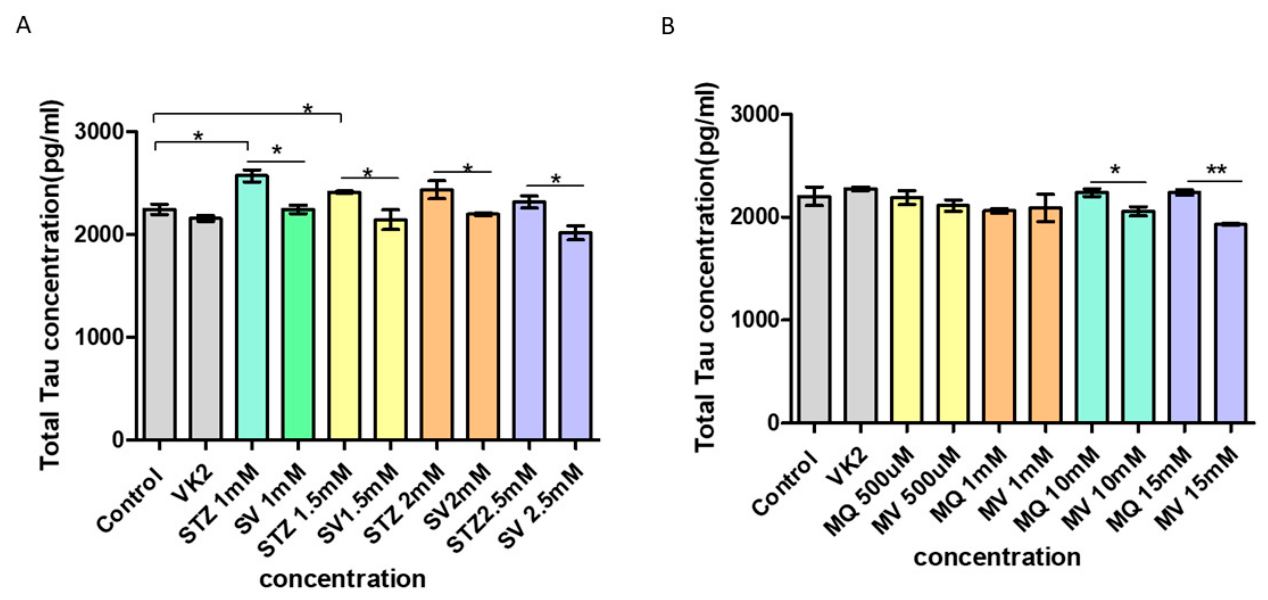
Figure 8. Measurement of total intracellular tau protein levels by ELISA in human SH-SY5Y neuroblastoma cells after ( A ) streptozotocin treatment and post-treatment with vitamin K2 (50 µ M) and ( B ) menadione treatment (MQ) and post-treatment with vitamin K2. A best-fit standard curve was plotted for the known protein concentrations using graph pad prism and absorbance values for unknown samples were interpolated on the standard curve to determine the concentration of target protein in each sample. The data are presented as mean ± SEM. Statistical analysis was performed using Student’s t -test and differences with p -value ≤ 0.05 were designated as significant. * p < 0.05, ** p < 0.01, and *** p < 0.001 denote significant differences compared to the control and between the treatment groups. [STZ—streptozotocin; VK2—vitamin K2; SV—post-treatment of streptozotocin (1–2.5 mM) treated cells with vitamin K2 (50 µ M); MQ—menadione; MV—post-treatment of menadione (500 nM–15 µ M)-treated cells with vitamin K2 (50 µ